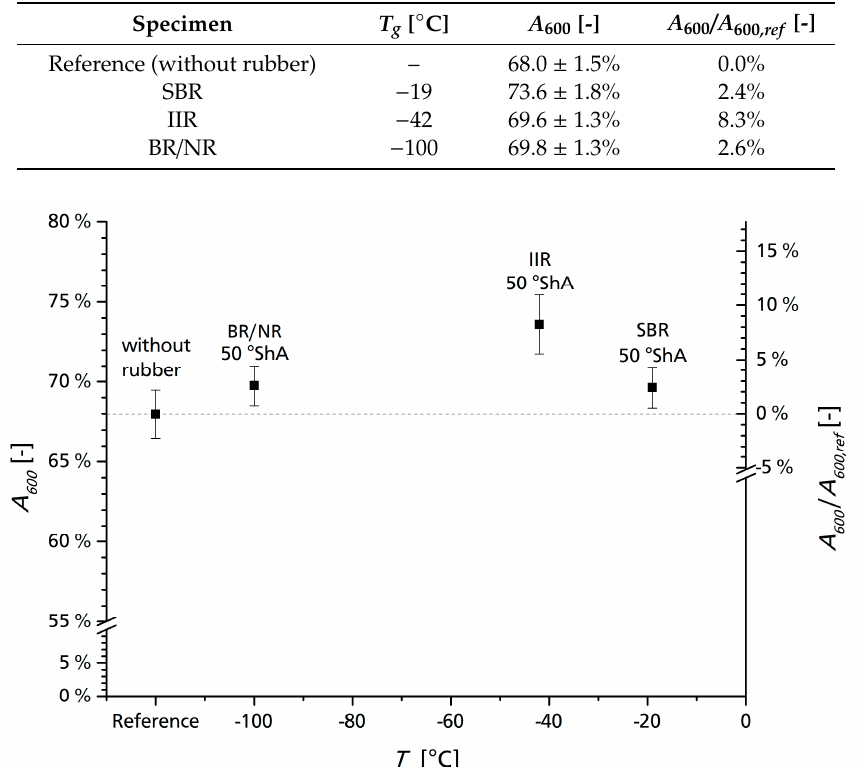
Table 5. Mean values of energy absorption A with a standardized impact velocity v 0 of 600 m / s for the investigated configurations with di ff erent rubbers.